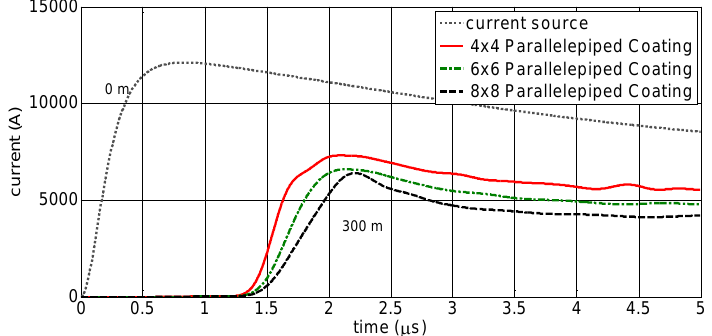
Figure 6. Current distribution along the lightning channel at height 300 m calculated by CST-MWS for a 4 × 4 m 2 , 6 × 6 m 2 , and 8 × 8 m 2 parallelepiped dielectric of ε r = 9 and σ = 0.0005 S/m. Model B1 : Wire embedded in a fictitious dielectric coating.